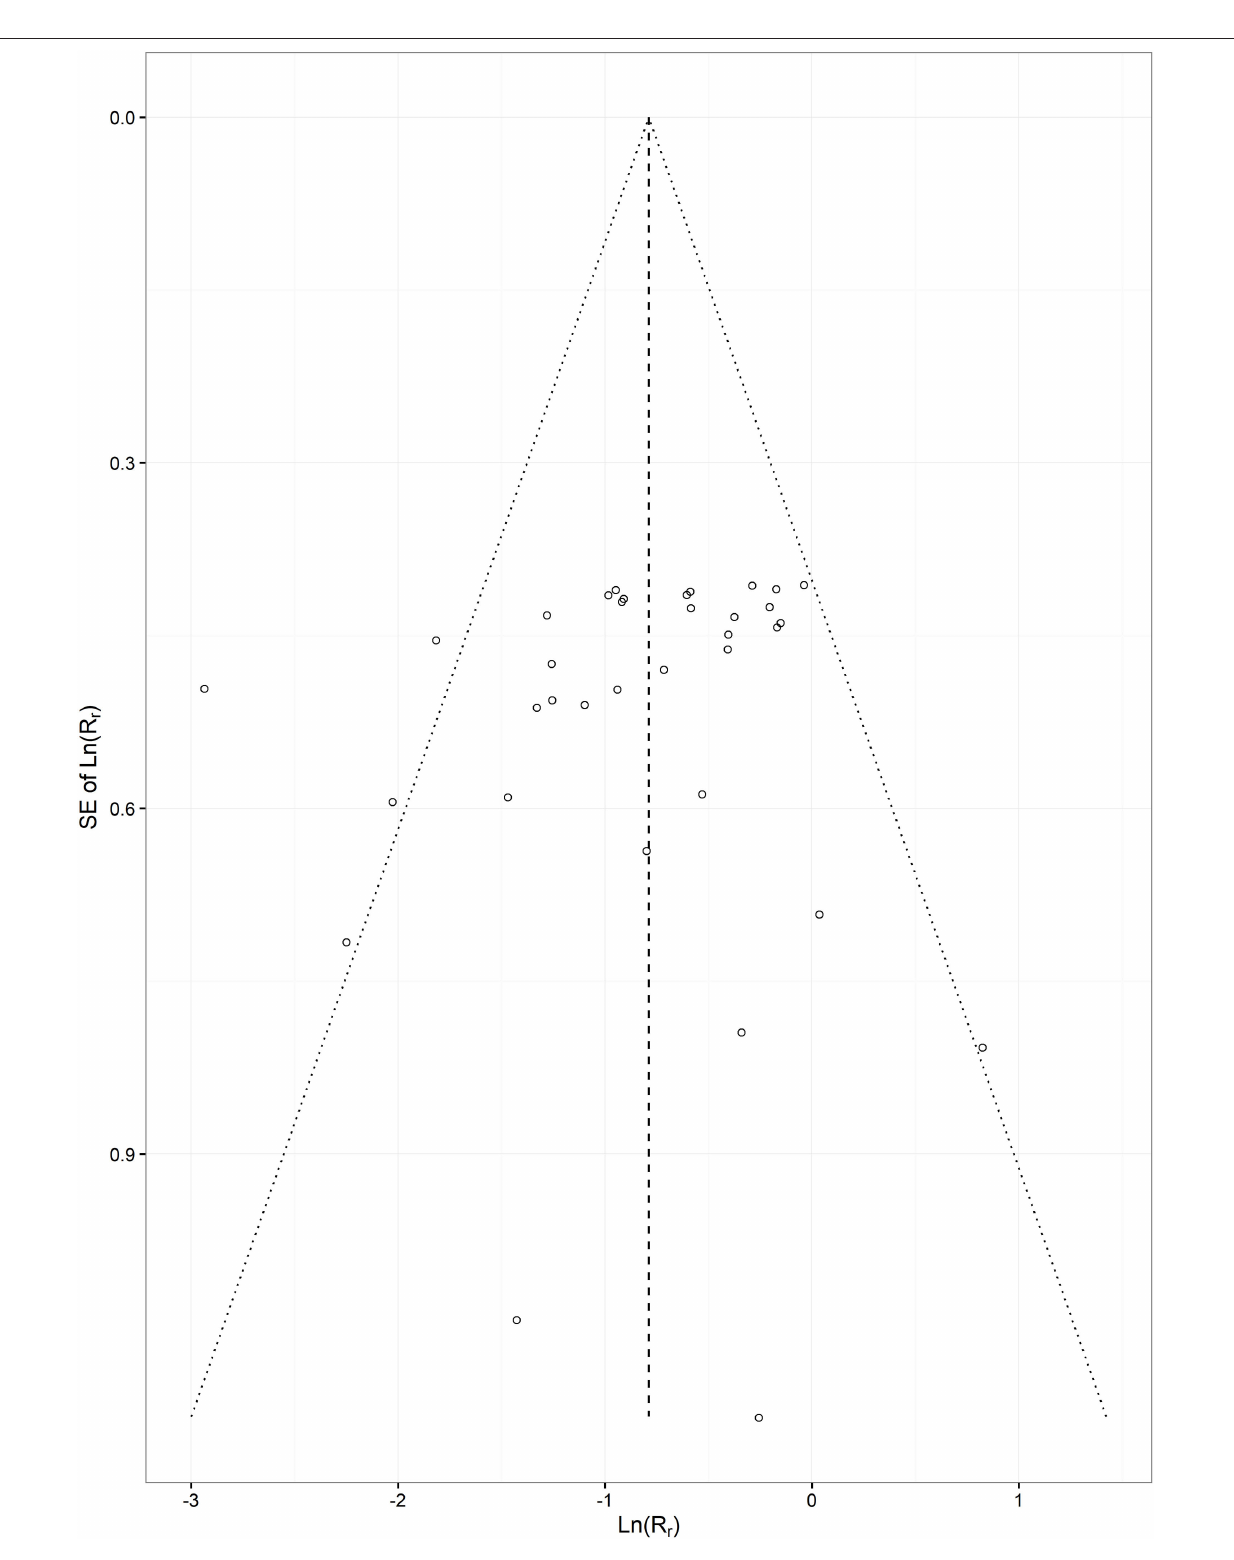
Frontiers in Water |